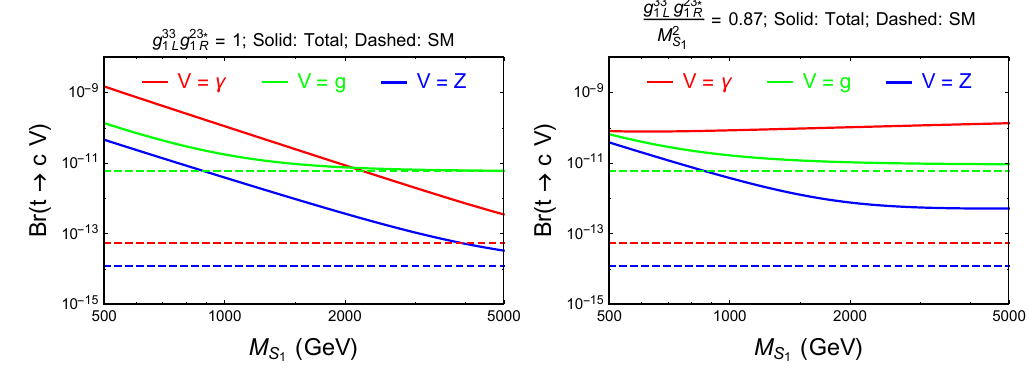
Figure 4 . Br ( t cV ) ; V = (cid:13); g; Z at one-loop level induced by SU(2) singlet scalar LQ S 1 . !